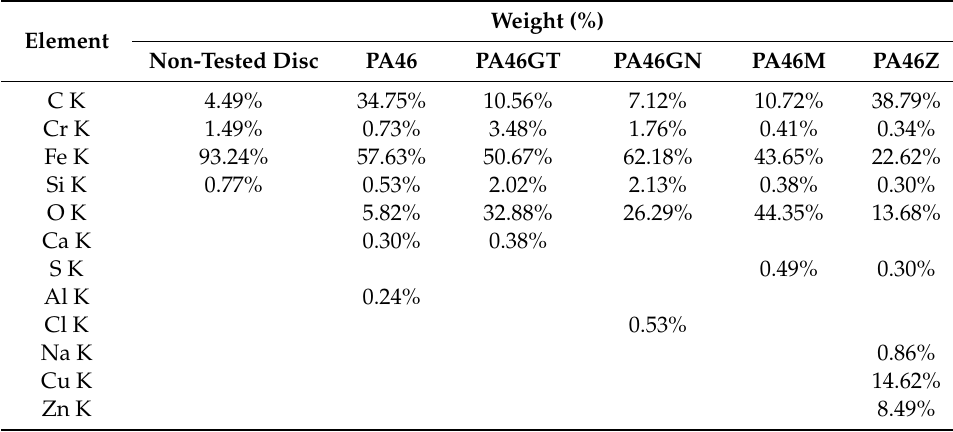
Figure 5. Worn surfaces of PA46 composites: ( a ) PA46 + 5% graphene; ( b ) PA46 + 5% graphite; ( c ) PA46 + 5% MoS 2 ; ( d ) PA46 + 5% ZrO 2 . Table 3. Summary of EDS spectra for PA46